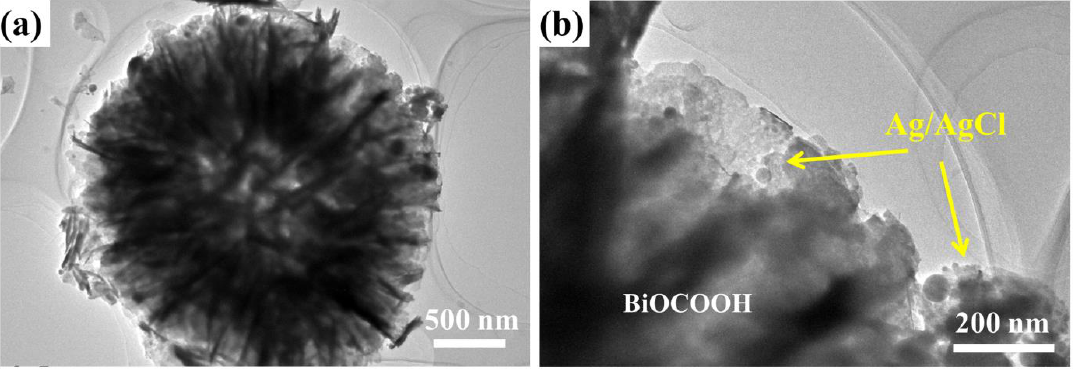
Figure 3. ( a , b ) TEM images of Ag/AgCl/BiOCH-3.